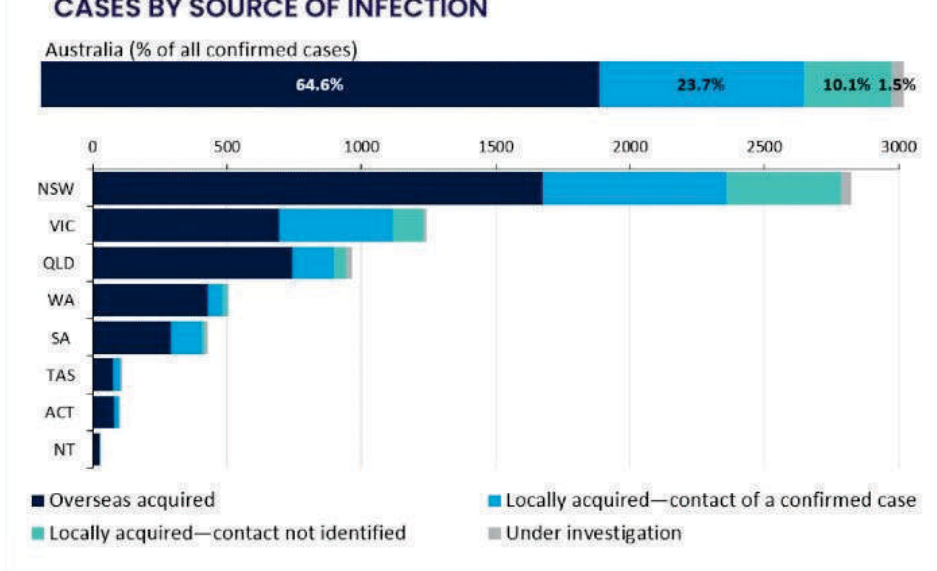
Figure 1: Changes in the proportion of category of cases over time